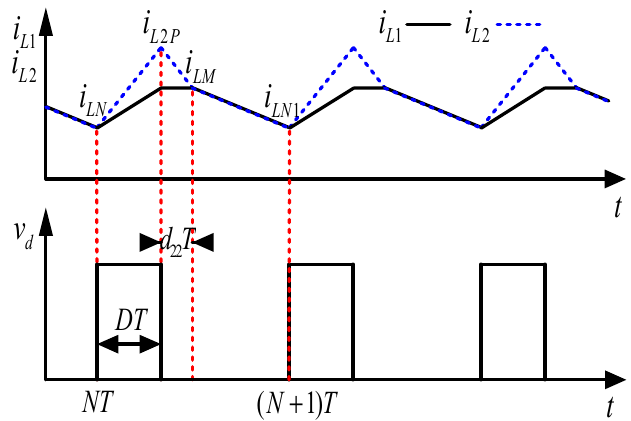
Figure 4. Typical time-domain waveforms about i L 1 , i L 2 and v d for the proposed step-up converter under L 1 > L 2 .